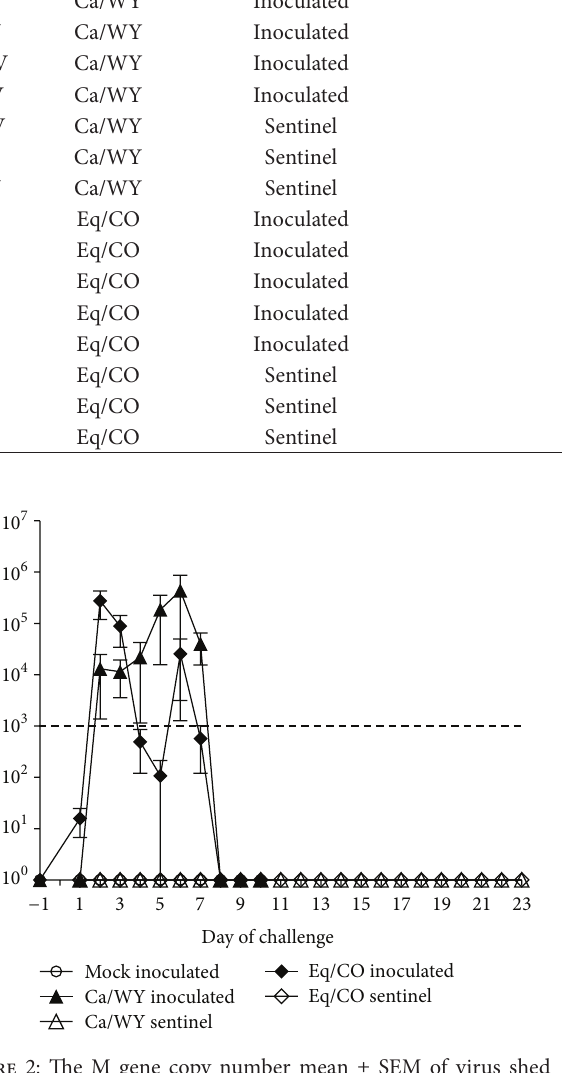
Figure 2: The M gene copy number mean ± SEM of virus shed in nasal passages for mock-inoculated ( ⃝ ), Ca/WY-inoculated ( 󳵳 ), Ca/WY sentinel ( △ ), Eq/CO-inoculated ( X ), and Eq/CO sentinel ( ⬦ ) dogs. The minimum detection level of the real-time RT-PCR was 1000 M gene copies per reaction corresponding to 10 3 TCID 50 of Ca/CO-1 and is represented by the dashed